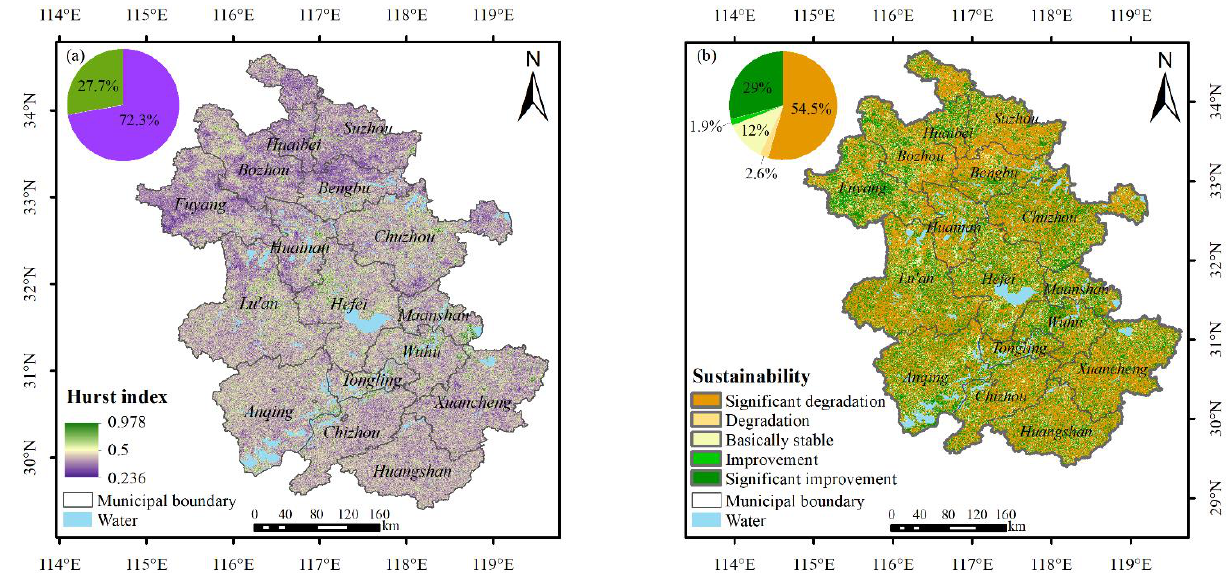
Figure 7. Sustainability of variations in EVI in Anhui Province during 2000–2020. ( a ) Hurst exponents of variation in the EVI. ( b ) Sustainability classification of variation in the EVI.